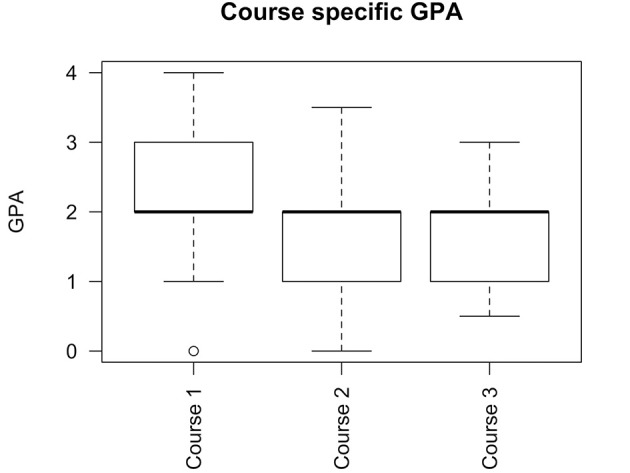
Course specific GPA. Boxplot showing median, 1st and 3rd quartile and 95% CI. A median GPA of 2 for all courses was observed.